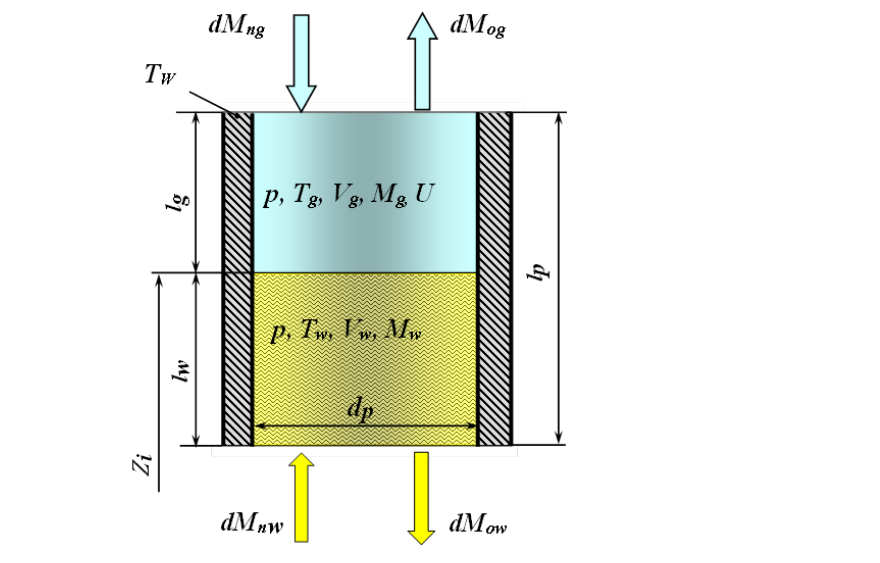
Figure 2. Design scheme of a cavity of constant volume, partially filled with liquid.